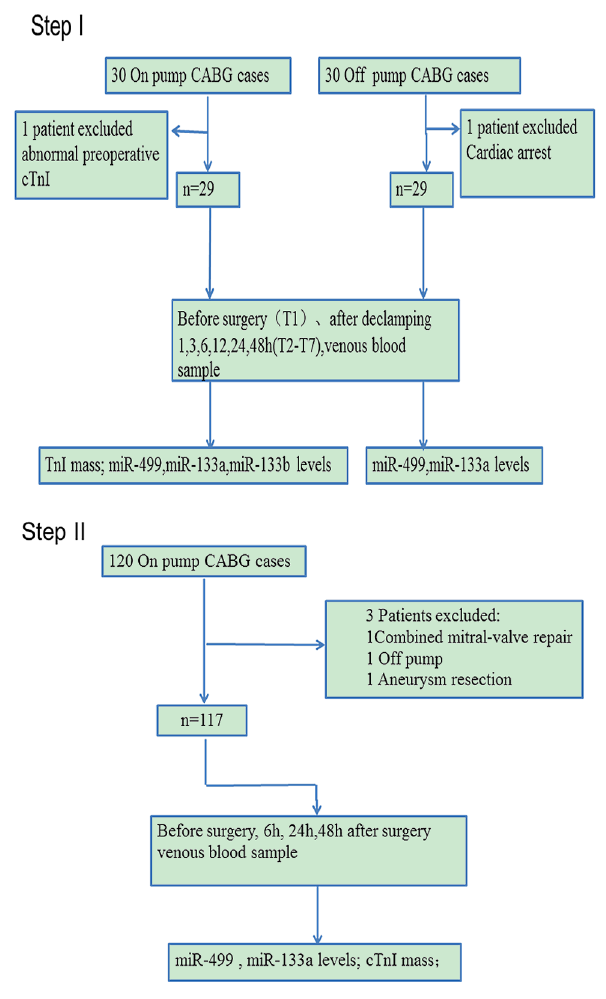
Figure 1. Study protocol. CABG, coronary artery bypass graft.